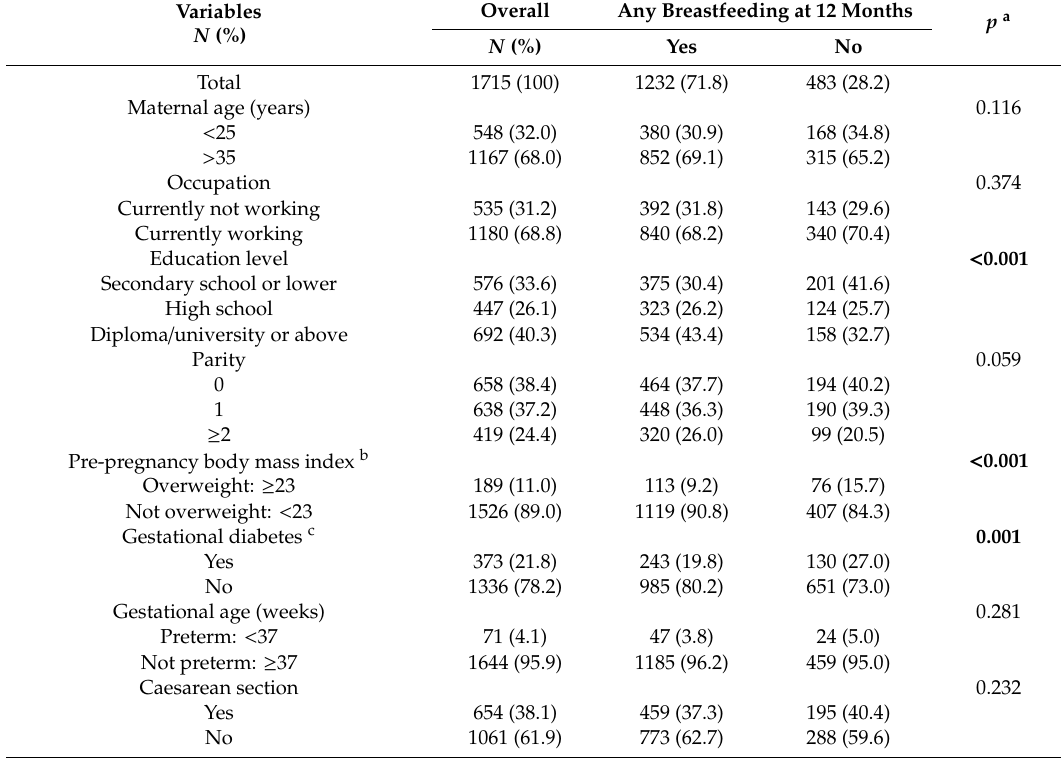
Table 1. Characteristics of participants by breastfeeding at 12 months ( N =